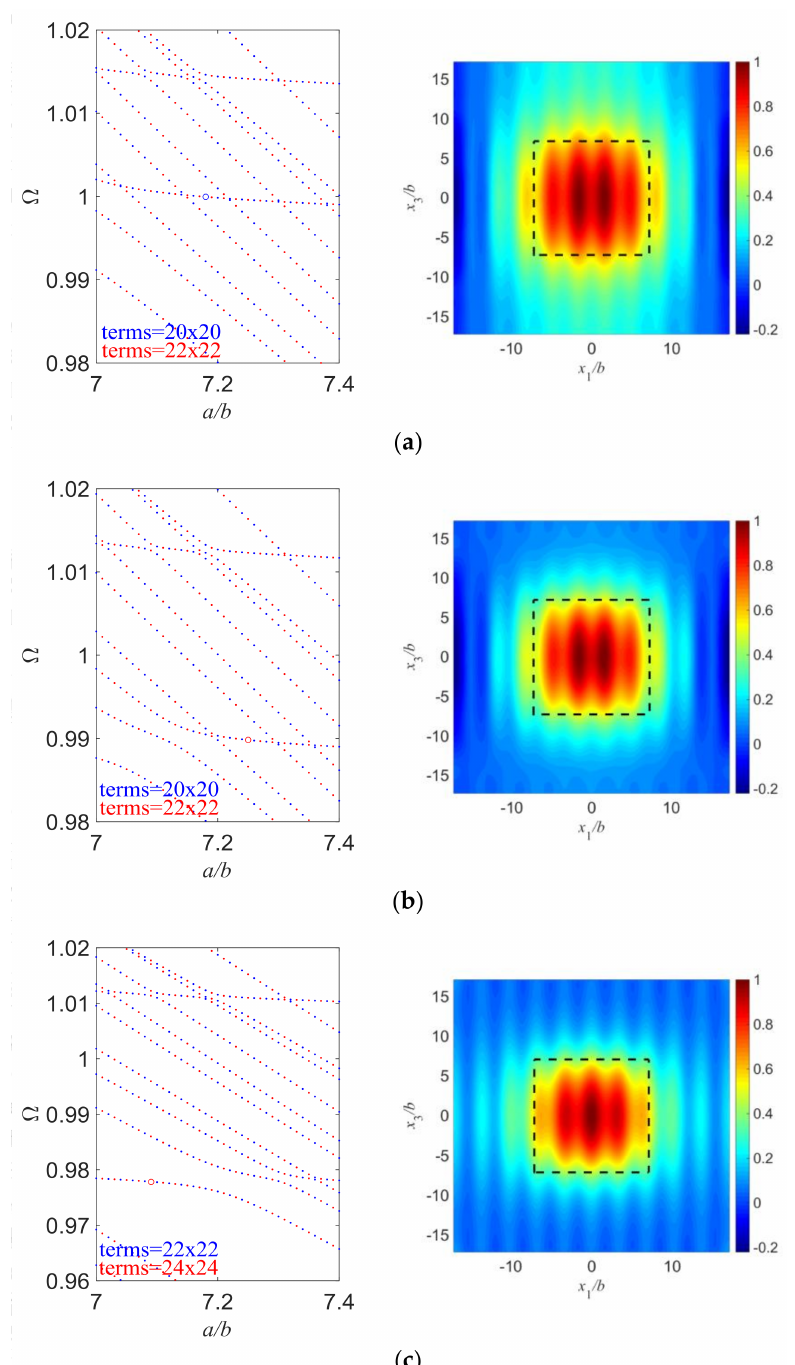
Figure 6. Essential TS modes with different R . ( a ) a / b = 7.18, d / b = 10, R = 0.01, Ω = 0.99995715; ( b ) a / b = 7.25, d / b = 10, R = 0.02, Ω = 0.98982614; ( c ) a / b = 7.09, d / b = 10, R = 0.03, Ω =